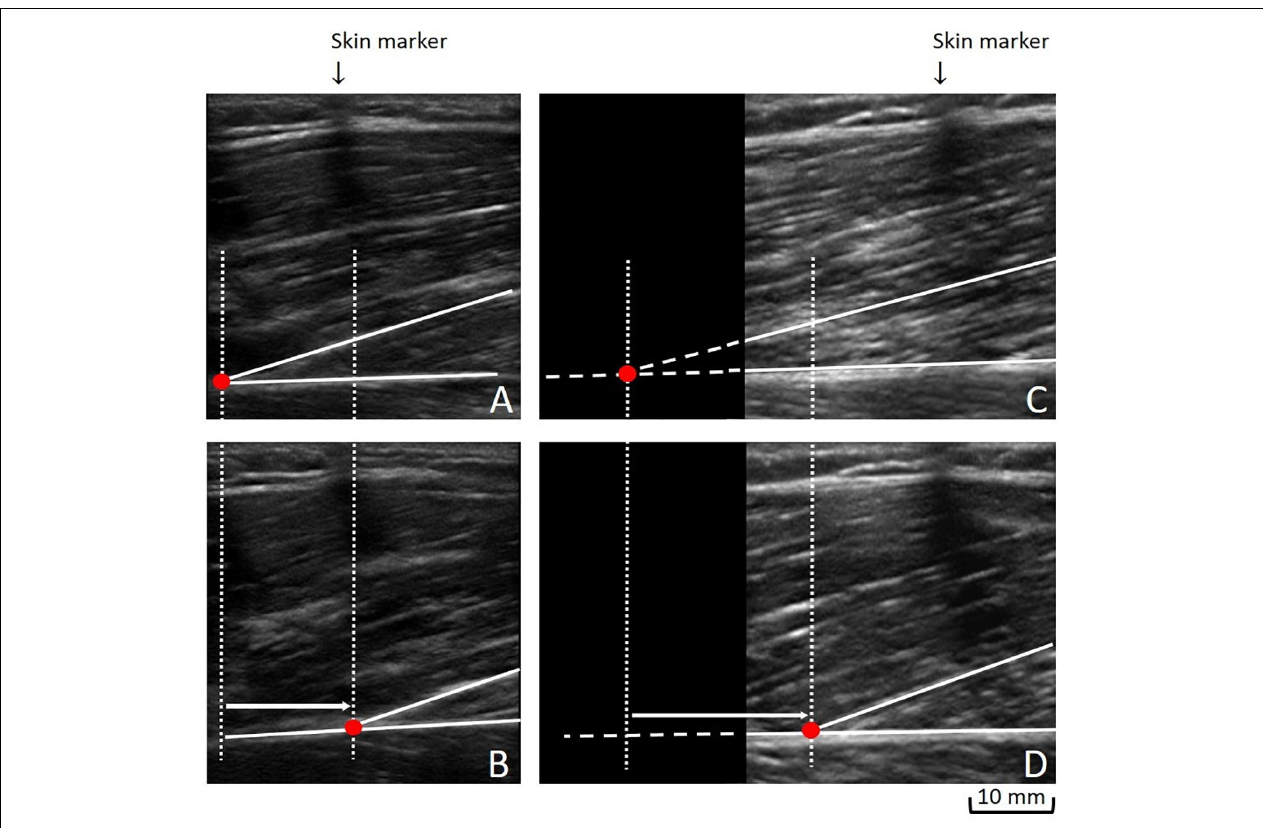
FIGURE 2 | Measuring the tendon-aponeurosis complex displacement: To obtain the tendon-aponeurosis complex displacement during neuromuscular electrical stimulation of each quadriceps muscle constituent, two approaches could be used: (1) We followed a fascicle’ deep insertion from rest (A) to maximal evoked contraction plateau (B) along its visible path. (2) When a fascicle’ deep insertion could not be entirely followed from rest (C) to the maximal evoked contraction plateau (D) , a linear extrapolation was performed (C)